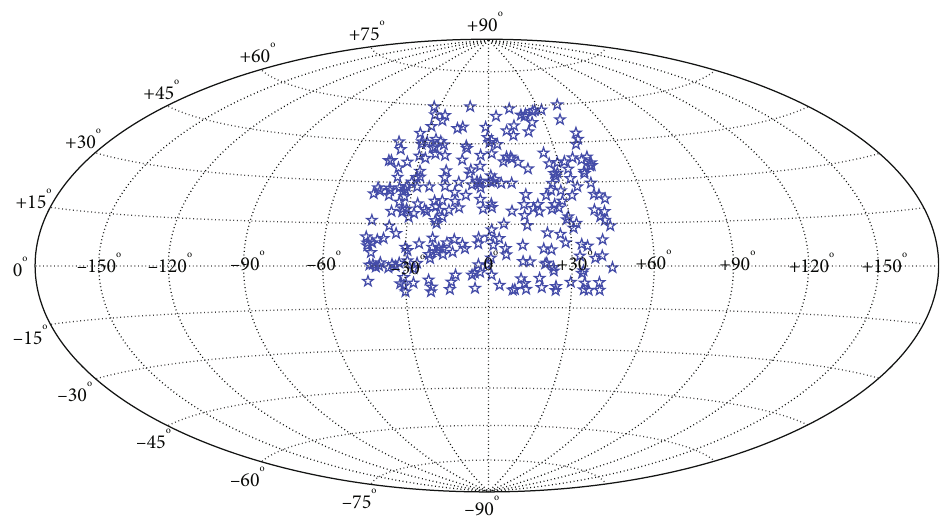
Figure 10: Arrow-borne navigation star database. Table 7: Local navigation star